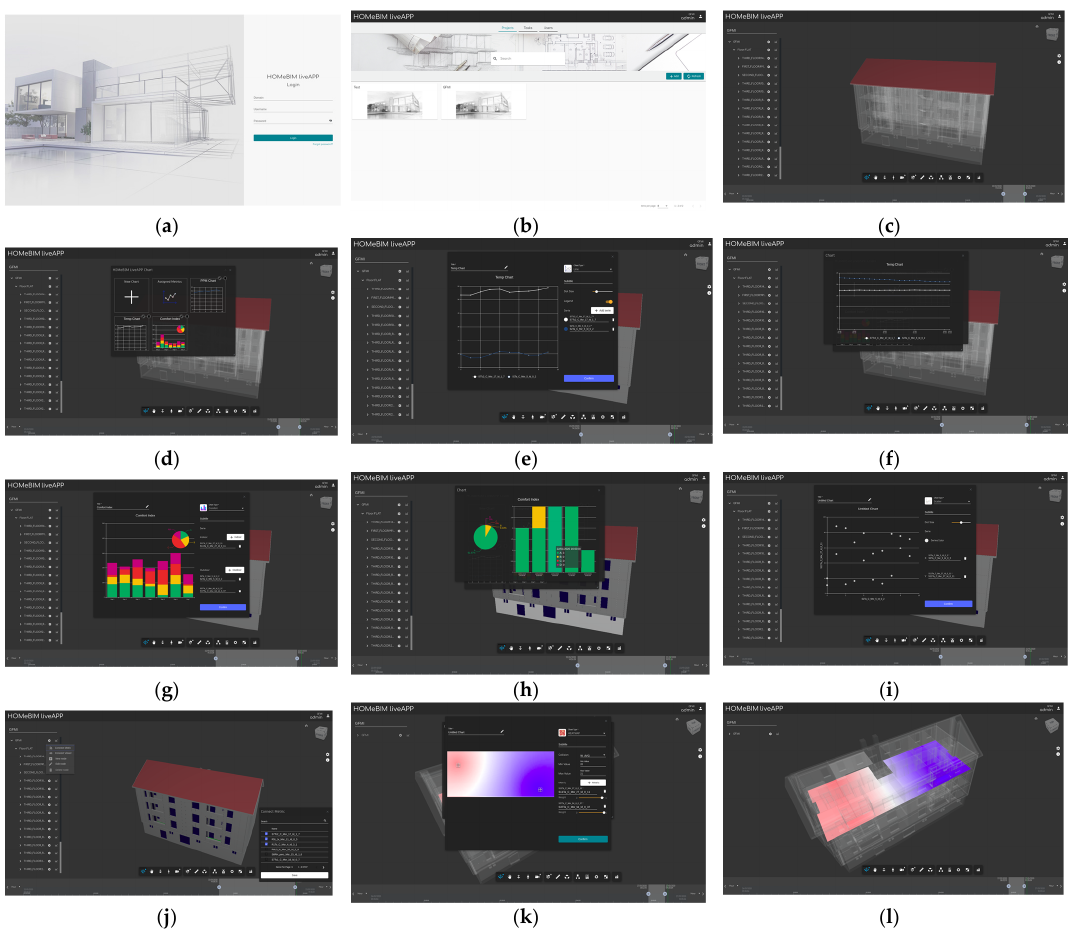
Figure 17. Four-dimensional multi-user Live App to improve building comfort, efficiency, and costs: from 3D survey to BIM sensor-based digital twin and cloud XR platform: ( a ) login; ( b ) upload model procedure; ( c ) project tree; ( d ) available charts in the app; ( e ) line chart of temperatures; ( f – i ) different comfort charts; ( j ) BIM parameters; ( k ) heatmap parameters; and ( l ) heatmap BIM visualisation.